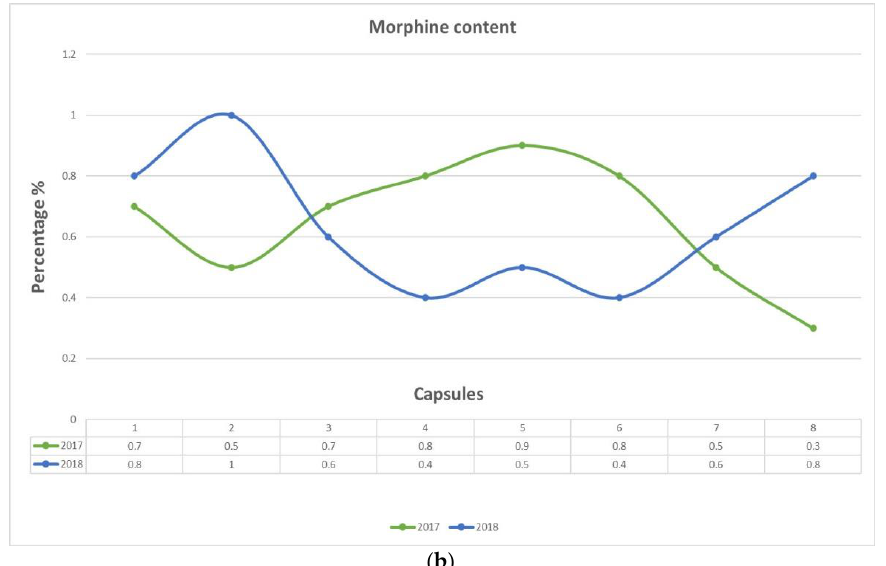
Figure 2. GC-FID chromatogram of the poppy extract ( a ) and a graphical representation of the morphine content variability in the analyzed samples ( b ).